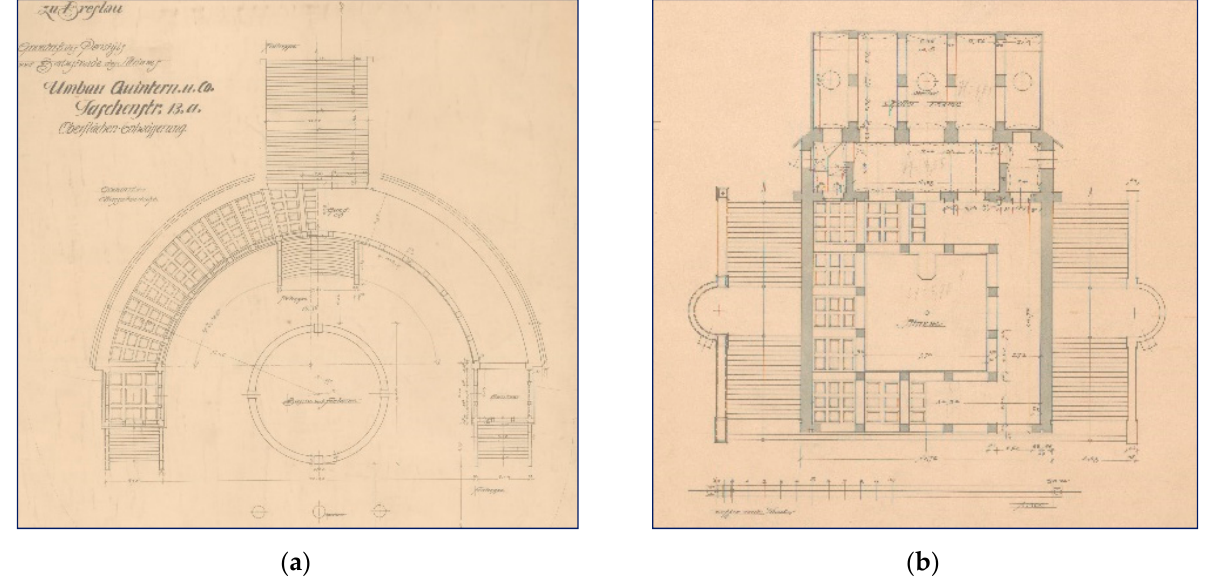
Figure 2. Extract from the original documentation of buildings existing to this day: ( a ) colonnades; ( b ) peristyle pavilion (source: archives of the Museum of Architecture in Wrocław, Poland).